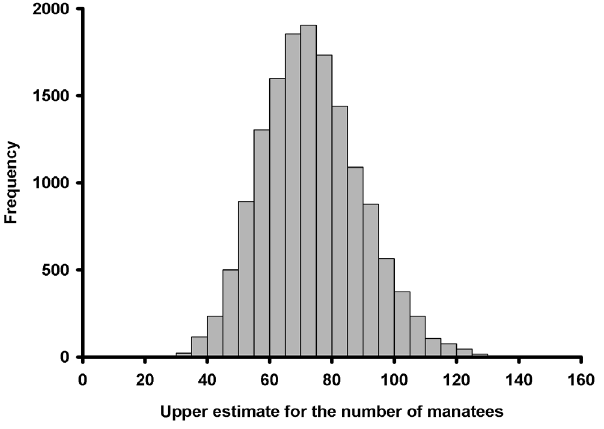
Figure 2. Posterior distribution of the upper estimate for the number of manatees in Florida ( ^ NN upper ) in manatee habitats potentially affected by the Deepwater Horizon oil spill during the